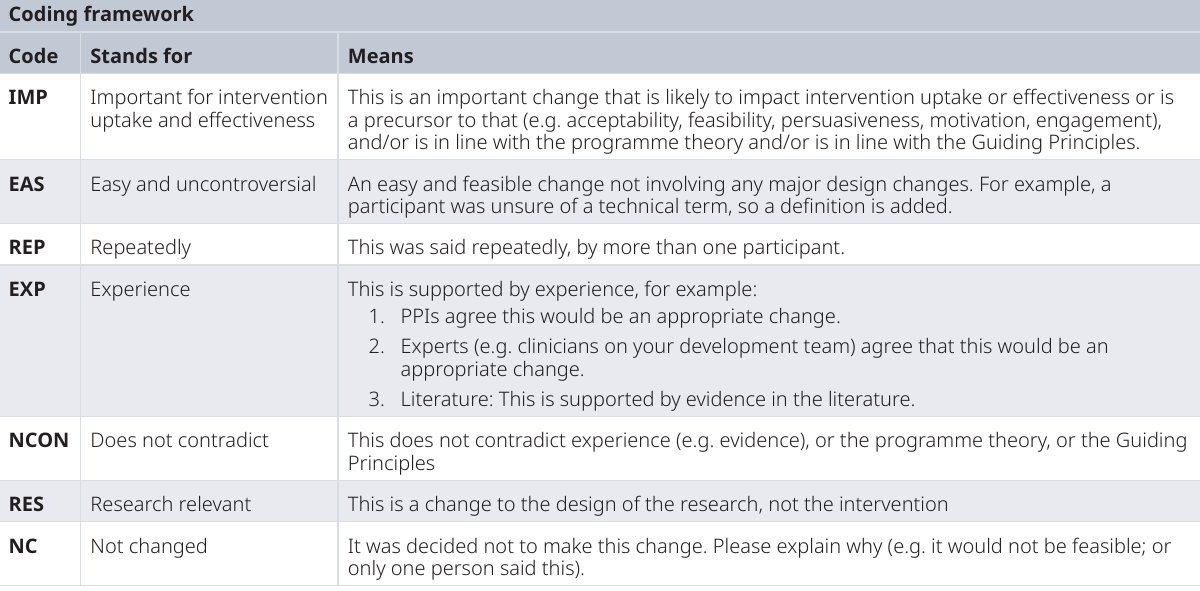
Table 1. Coding framework for Table of Changes. Coding